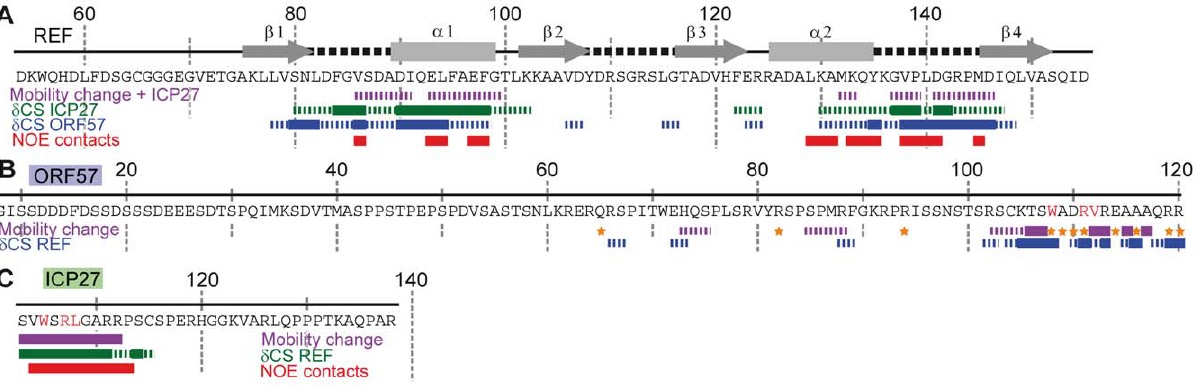
Figure 2. Identifying interaction sites within REF, ORF57 and ICP27 constructs via different NMR parameters. The detailed data is presented in SI. Purple solid and broken bars mark residues with large and moderate reduction of mobility upon binding, respectively, as evidenced by the increase in 15 N{ 1 H} NOE. Orange stars mark residues with amide signals broadened beyond detection in the complex. Large and moderate chemical shift changes ( d CS) of amide signals for each ligand as labelled are shown as solid and broken bars, respectively. Red bars mark residues forming direct inter-molecular NOE contacts in REF-ICP27 complex. ( A ) Changes in REF 54–155 induced by addition of ICP27 103–138 and ORF57 8–120 . Position of secondary structure elements of REF ( b -sheets, a -helices and loops) is shown in relation to its sequence. ICP27 and ORF57 bind on the same site on the REF RRM domain, with a -helices 1 and 2 and adjacent loop regions. ( B ) Changes in ORF57 8–120 upon addition of REF 54–155 . The main REF-interaction site is mapped to residues 103–120. ( C ) Changes in ICP27 103–138 induced by addition of REF 54–155 . The REF-binding site is mapped to residues 104-112.